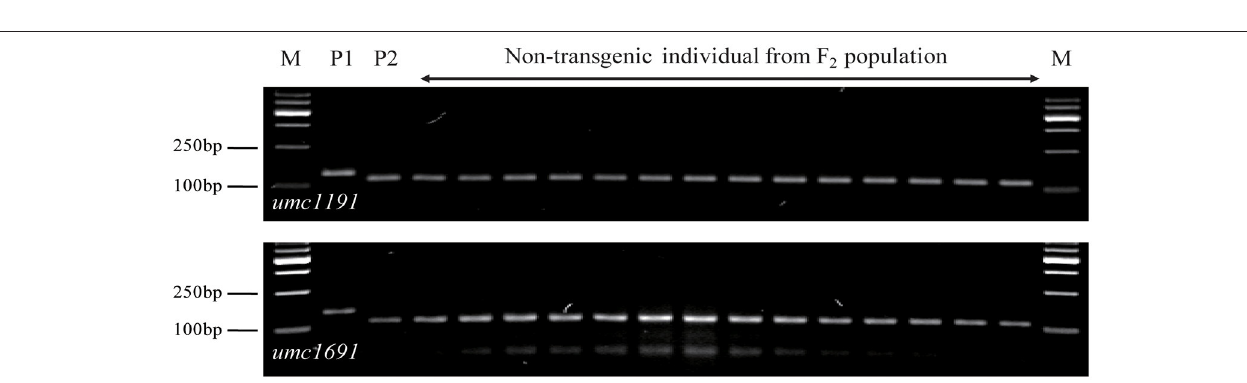
FIGURE 4 | Comparing the extended sequence from similarity of 257 sites at different lengths, separately. The x -axis shows the different lengths (0.5–7.5Kb, step length of 0.5Kb) extended at the left border (LB) and right border (RB) regions, respectively. The number is denoted on the y -axis.